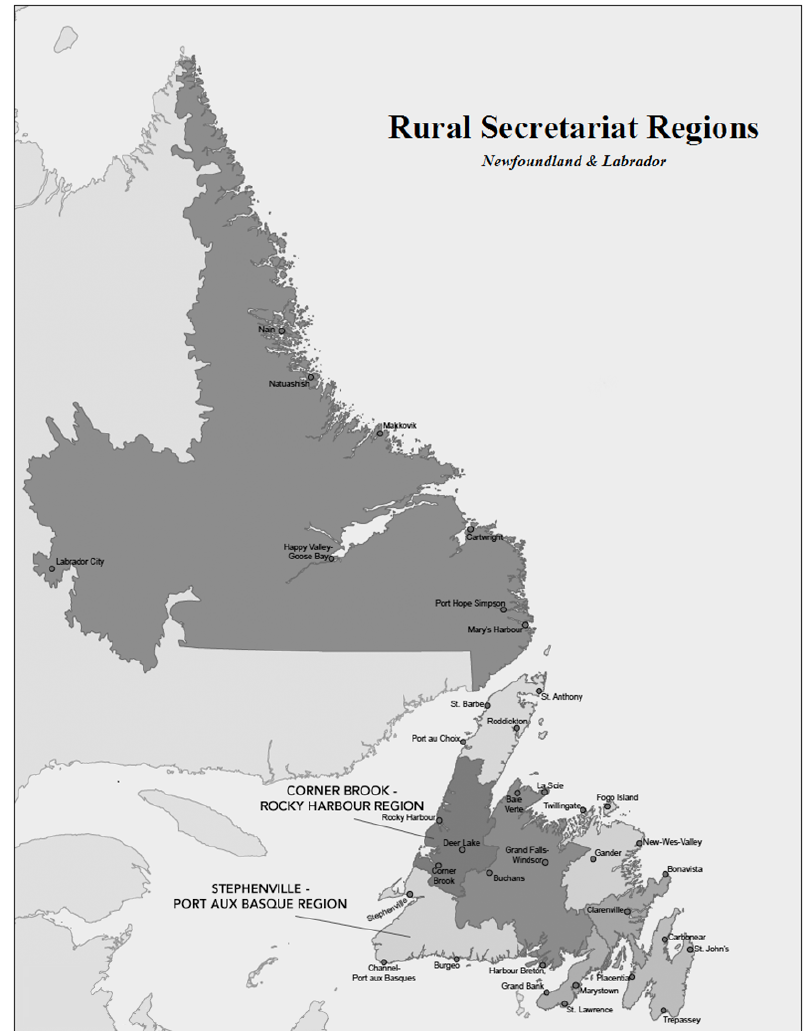
Figure 1: Map of